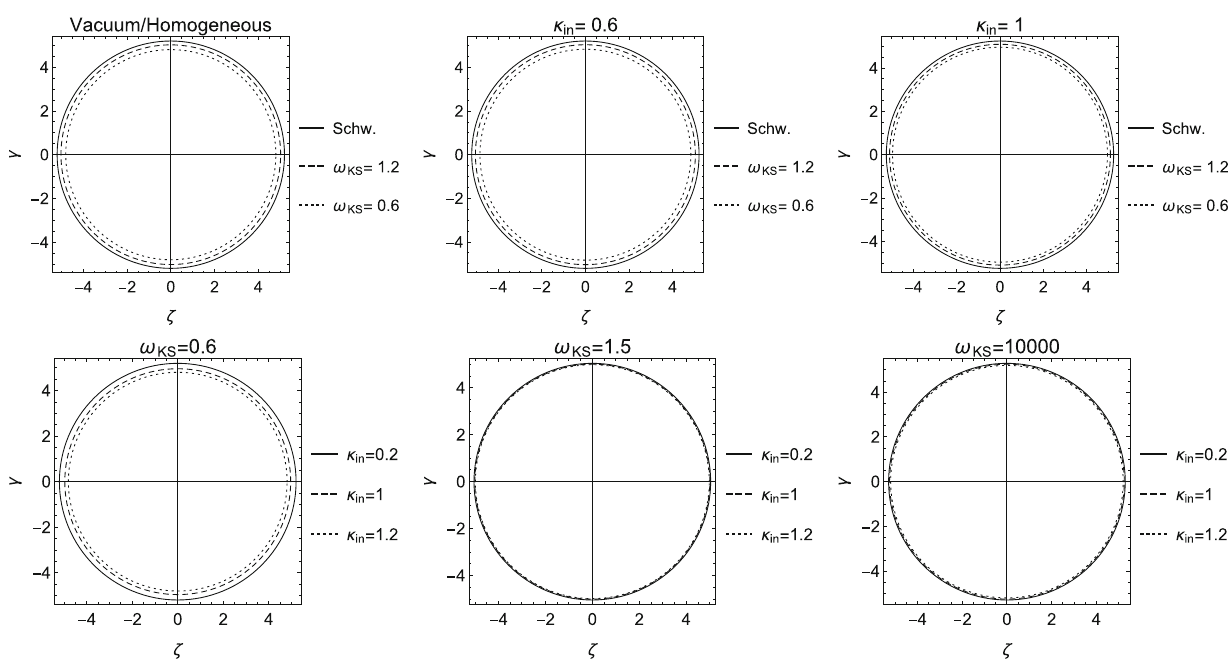
Fig. 2 Shadows KS black holes. The top left corner image is for vacuum/homogeneous case and rest of the figures are plotted for various combinations of the “Hoˇrava” parameter and the plasma parameter for inhomogeneous distribution of plasma